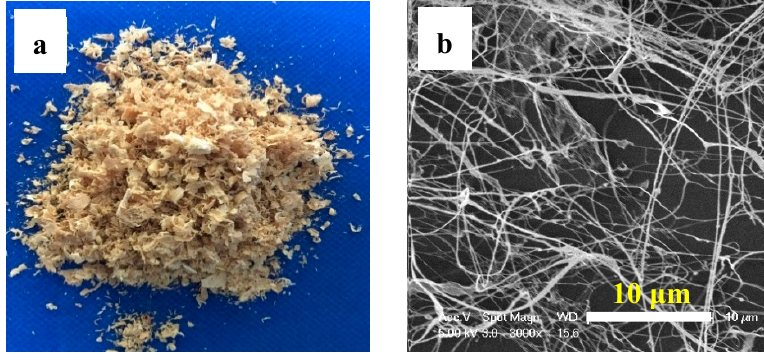
Figure 2. ( a ) Optical images of industrial bamboo residues (IBR) and ( b ) SEM images of as-prepared HCNF suspension with 0.01 wt%. Table 1. The chemical composition of industrial bamboo residues.